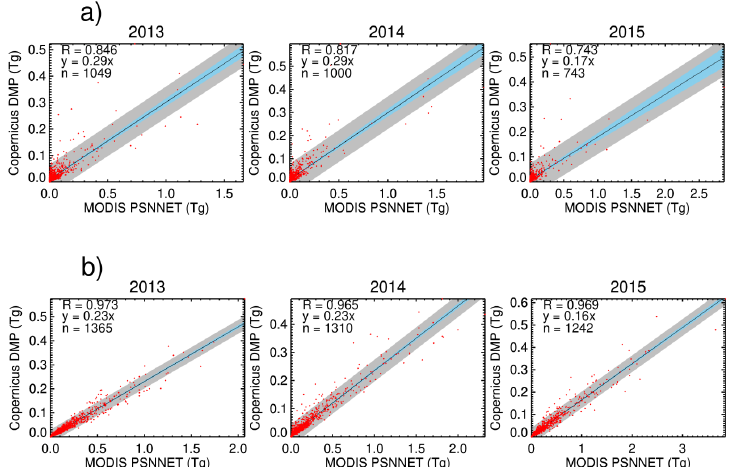
Figure 3. Comparison between MODIS net photosynthesis (PSN) (Tg) and Copernicus dry matter productivity (DMP, Tg DM) estimates that have been temporally integrated over MODIS burned areas that burned in successive years in the northern ( a ) and southern ( b ) African hemispheres. The grey shaded area represents the prediction interval and the blue shaded area is the slopes 95% confidence interval. Note that the x - and y -axis range differs among plots.